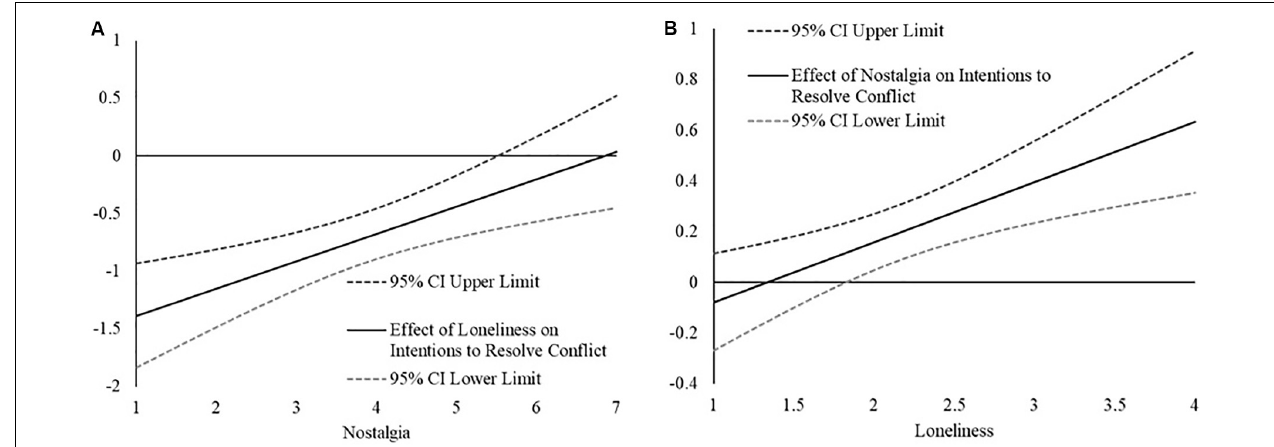
FIGURE 3 | (A) The plot represents the estimated relation between loneliness and intentions for overcoming social conflict ( y -axis) across the range of nostalgic feelings ( x -axis) in Study 2. The relations are considered statistically significant if the confidence intervals for the effect (CI) do not contain 0. (B) The plot represents the estimated relation between nostalgic feelings and intentions for overcoming social conflict ( y -axis) across the range of loneliness scores ( x -axis) in Study 2. The relations are considered statistically significant if the confidence intervals for the effect (Cl) do not contain